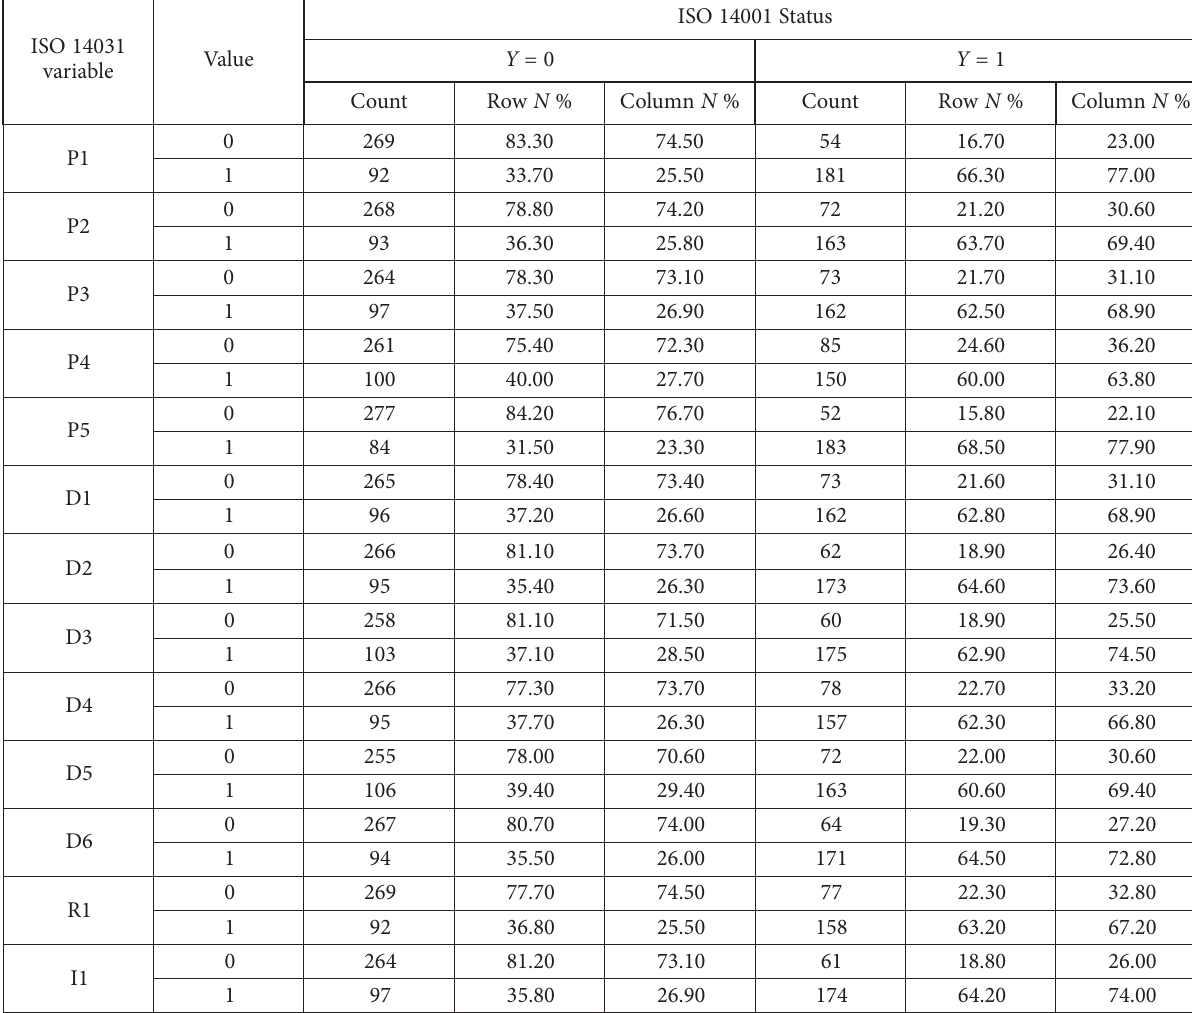
Table 3. Frequency table for the environmental performance evaluation independent variable